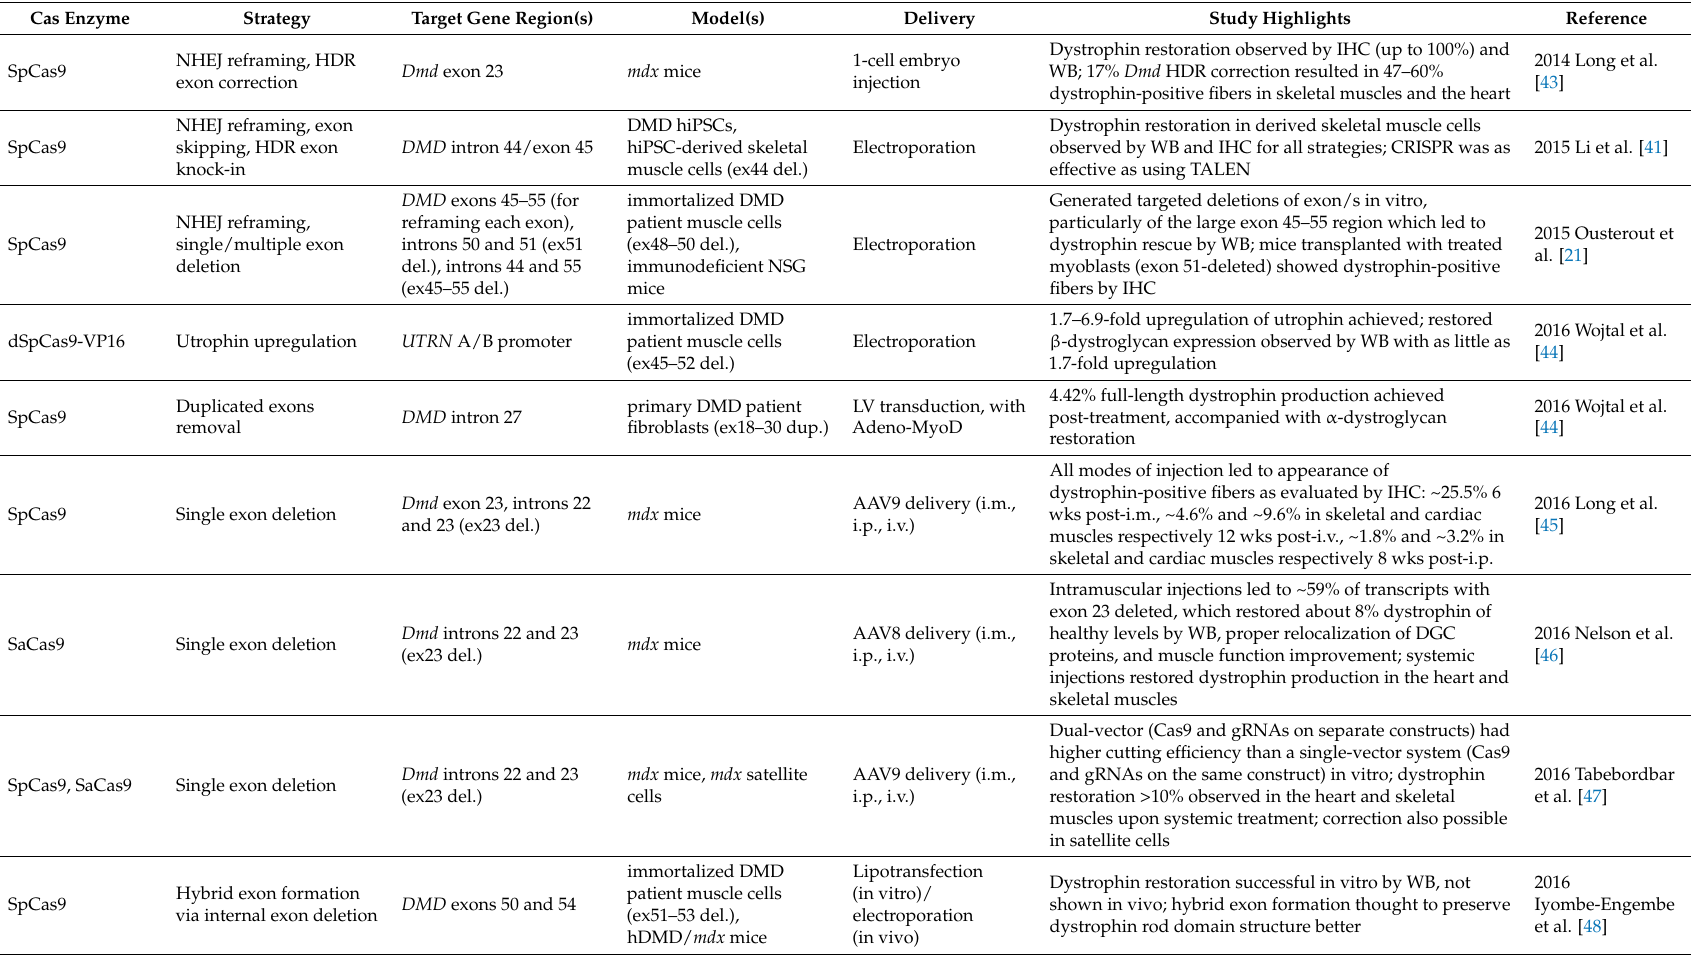
Table 2. Summary of studies that have used CRISPR/Cas9 approaches for the treatment of